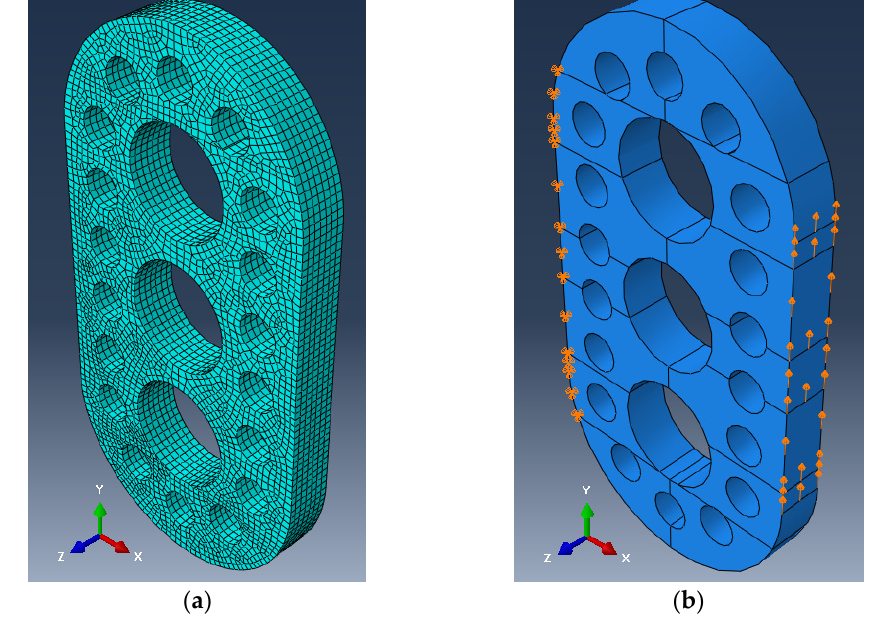
Figure 7. FEM model of the MYZ device: ( a ) mesh; ( b ) boundary conditions.